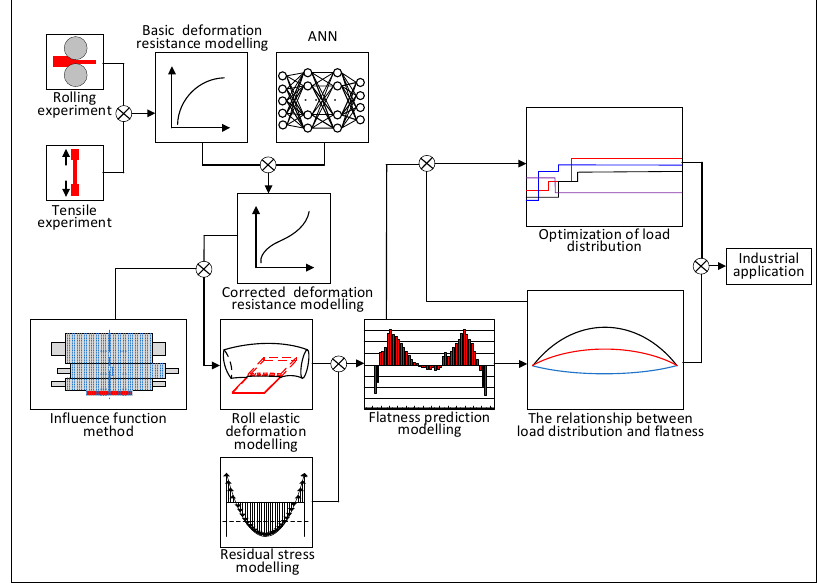
Figure 1. The technical routes of the present research.